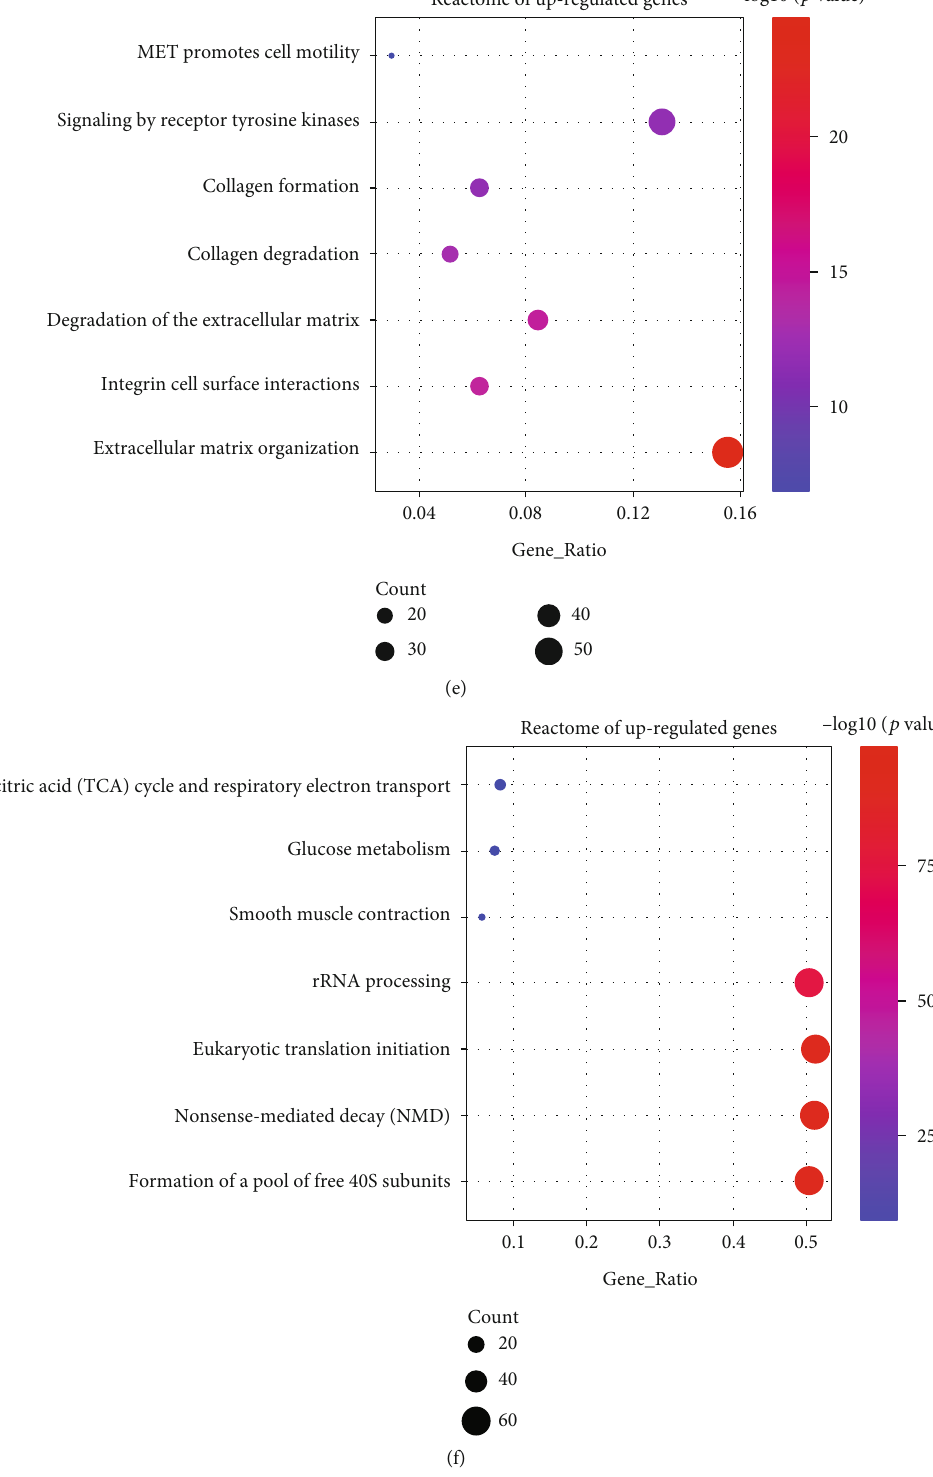
Figure 4: Recollected (ADSC_rec) ADSCs showed a di ff erent single-cell transcriptomic pro fi le compared to cultured ADSCs (ADSC_cul). (a) UMAP distribution of in vitro cultured (ADSC_cul) and recollected (ADSC_rec) ADSCs merged into one dataset. (b) UMAP distribution of all 10 clusters identi fi ed by Seurat in merged dataset of ADSC_cul and ADSC_rec. (c) Cell count of every cluster in two ADSC groups. (d) Violin plots of di ff erentially expressed genes between ADSC_cul and ADSC_rec groups. (e, f) REACTOME pathway enrichment terms of di ff erentially expressed genes ((e) upregulated genes, (f) downregulated genes) in ADSC_rec group compared to ADSC_cul group. Genes were fi rst fi ltered by a condition of log2 fold change > 0.5 or < -0.5 and adjusted P value <